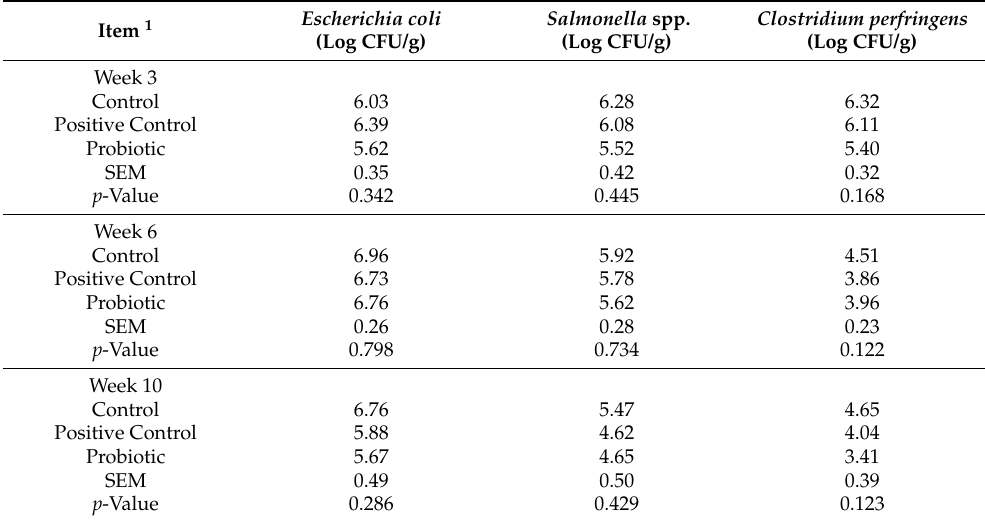
Table 5. Effect of different dietary treatments on microbial load of Escherichia coli, Salmonella spp., and Clostridium perfringens in the